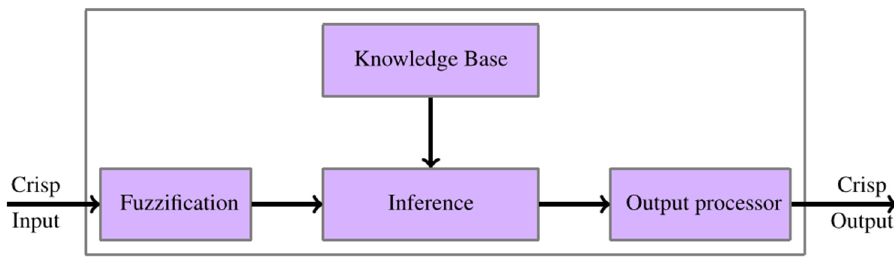
Figure 2. An interval type-2 fuzzy system.